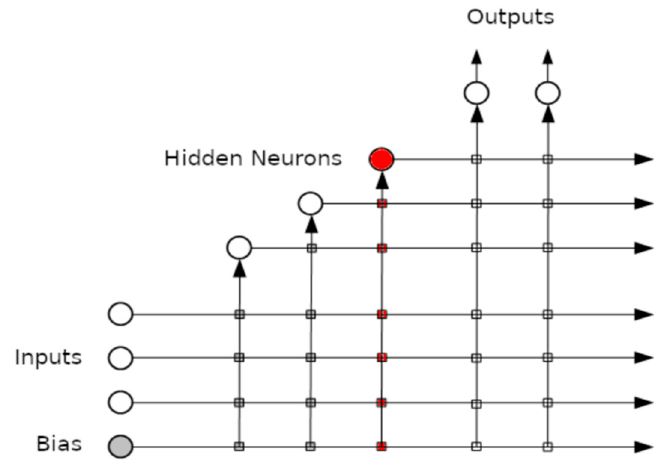
Figure 1. The cascade correlation neural network after adding three hidden layers.